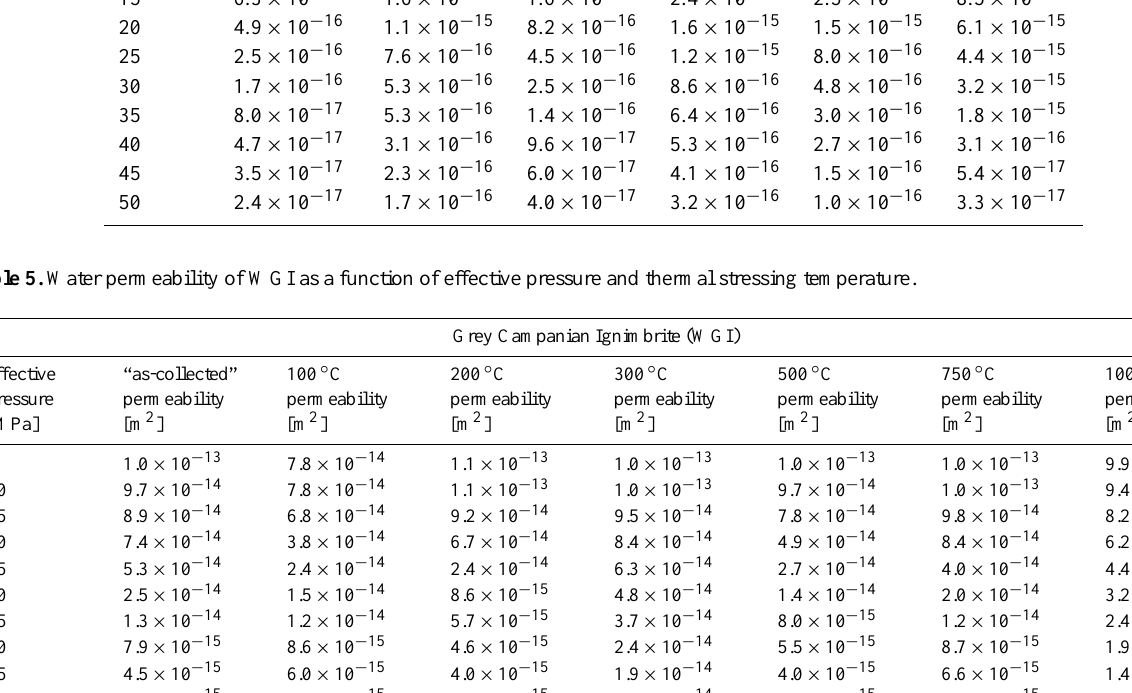
Table 4. Water permeability of NYT as a function of effective pressure and thermal stressing temperature.